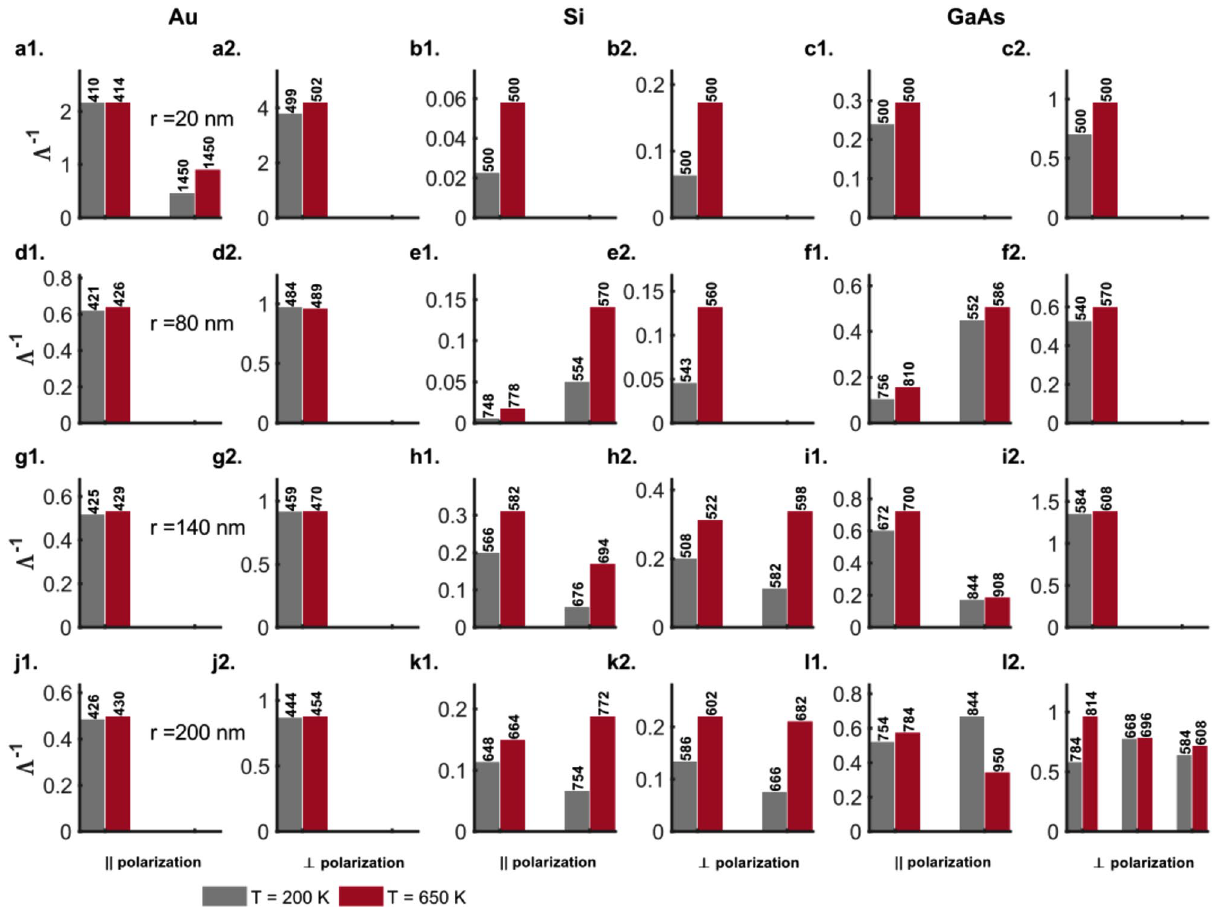
abs (cid:31) abs Figure 9. Inverse of the ratio ( (cid:31) ) of scattering efficiency ( Q sca ( (cid:31) res ) ) to the absorption efficiency ( Q abs ( res ) ) as a measure of the radiative to dissipative damping for the TM ( E ) and TE ( E ) polarizations of the incident (cid:31) ⊥ radiation for ( a1 , d1 , g1 , j1 ; a2 , d2 , g2 , j2 ) Au (DL model), ( b1 , e1 , h1 , k1 ; b2 , e2 , h2 , k2 ) Si and ( c1 , f1 , i1 , l1 ; 200 (grey 20, 80, 140 and 200 nm , respectively, at temperatures T c2 , f2 , i2 , l2 ) GaAs nanowires of radii r = = bars) and 650 (maroon bars) K . The numbers on top of the bars indicate either the wavelengths (in nm ) at which the absorption resonances occur or the maxima in absorption efficiency in the wavelength range under consideration in the case of the thin ( 20nm ) wires. Here, the Mie computations for the nanowires of different sizes take into account their thermal expansion, although the text labels indicate the values for nanowire radii at 200 K